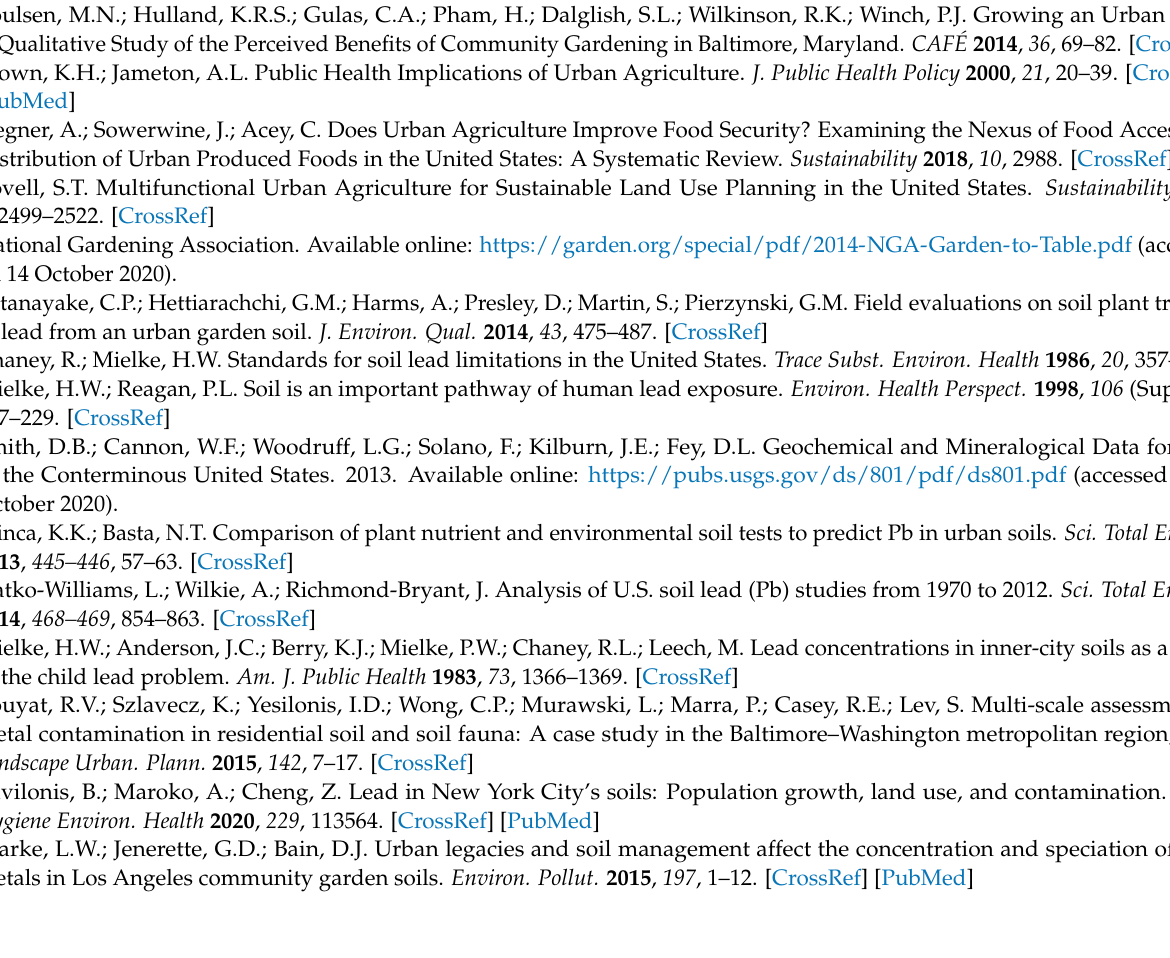
( I geo ). Table S4: Calculated mean and median concentration of Pb (in mg kg − 1 ) across sites and categories for single-step extractions. The mean and median value for all samples is indicated in italics. Table S5: Average Pb concentration in soil fractions for all samples collected in the study. Table S6: Calculated median concentration of Pb (in mg kg − 1 ) across categories for sequential extractions. The median value for all samples in each fraction is indicated in italics. Table S7: Extractable Pb concentration, and Pb associated with soil fractions collected for hotspot (HS) identification. Table S8: Extractable Pb concentration in various particle size fractions of selected samples. Table S9: The structural parameters derived from EXAFS analysis of samples including error reported in analysis (shown in italics). Table S10: EXAFS parameters for Pb compounds from the literature and analyzed soil